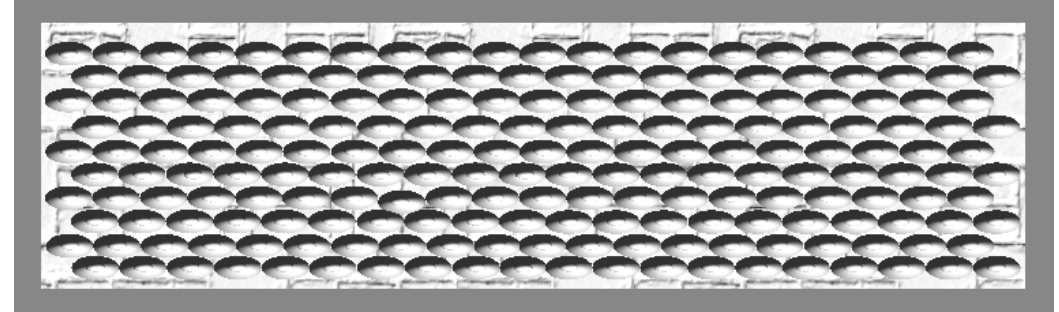
Figure 5. A total of 200 agents are packed hexagonally with three fixed walls, while the wall at the bottom moves upwards in the simulation.